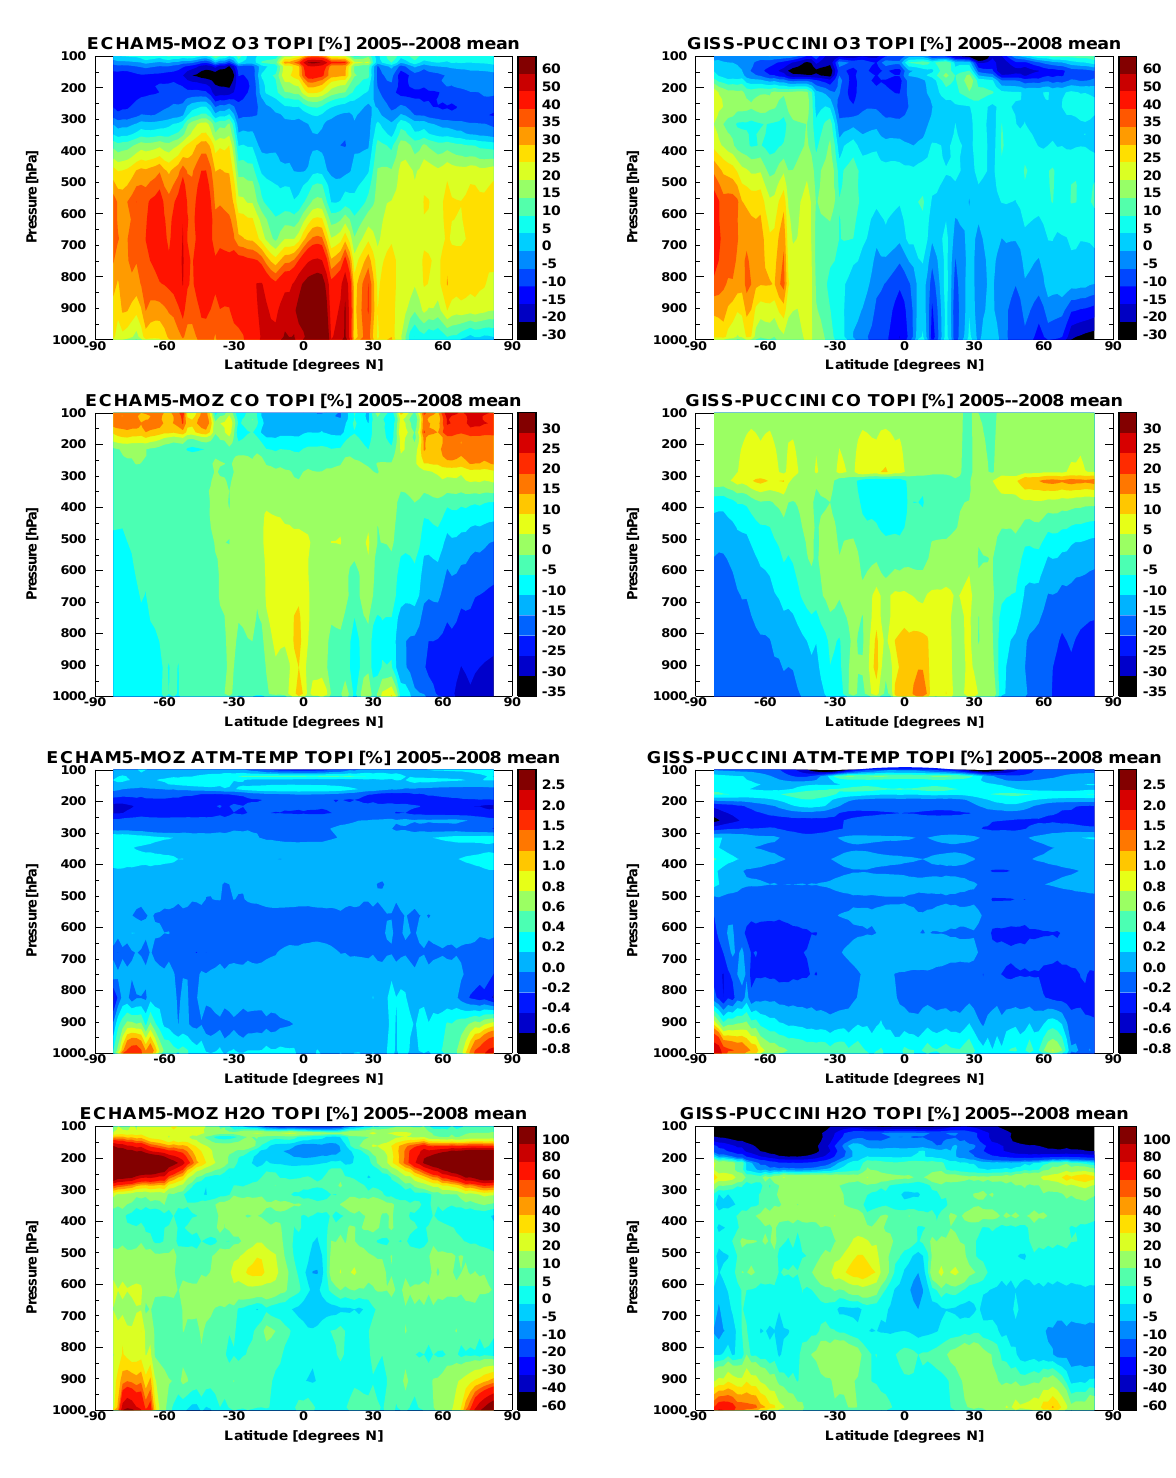
Fig. 9a. The 2005–2008 monthly-mean zonal average of the percentage error encountered for failure to account for the limited vertical resolution of the nadir satellite. We show this impact on the ECHAM5-MOZ (left column) and the GISS-PUCCINI (right column) ozone, carbon monoxide, atmospheric temperature and water vapour on rows one, two, three and four,